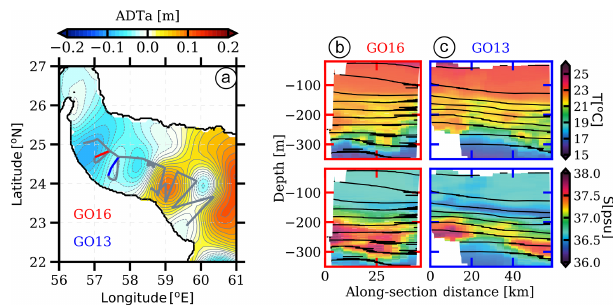
Figure 2. (a) Map of the absolute dynamic topography anomalies in the Gulf of Oman averaged over the duration of the cruise processed by CLS-Argos on a 1 / 8 ◦ Mercator grid. The solid grey lines indi- cate the locations of the Seasoar sections. The solid orange and blue lines indicate sections GO16 and GO13, respectively. (b, c) Tem- perature (top) and salinity (bottom) vertical sections of GO16 and GO13 sections, respectively, showing the warm and salty PGW out- flow settled down to about 250m depth in the Gulf of Oman. Black contours stand for